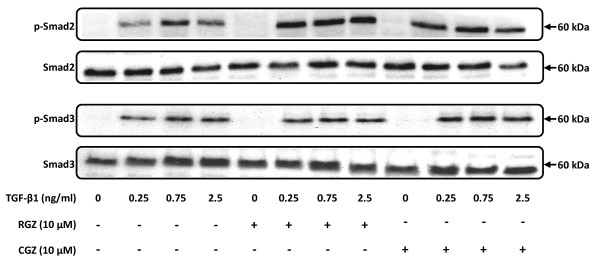
Regulation of TGF-β1-induced phosphorylation of Smad2 and Smad3 by PPARγ ligands. Cell lysates were prepared from A549 cells pre-treated with vehicle, RGZ (10 μM) or CGZ (10 μM) for 1 hr and then treated with TGF-β1 at the indicated concentrations for 1 hr. The Western blot is representative of 3 separate experiments.